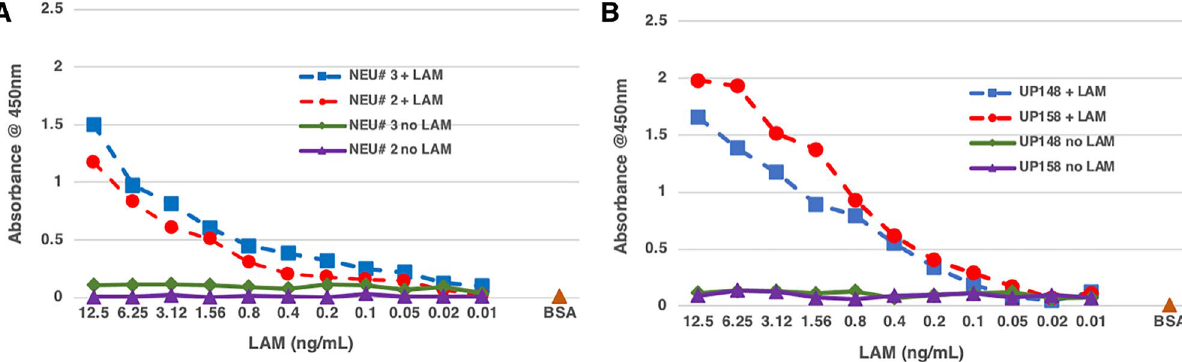
Figure 2. Capture ELISA showing LAM standard curve. Urine from two healthy volunteers (NEU#2, NEU#3) from a TB non endemic region and two clinical samples (UP148, UP158) that were collected from clinically TB negative patients in a TB endemic region were spiked with known amount of LAM and serially diluted two fold (ranging from 12.5 to 0.02 ng/mL) to derive a standard curve and pretreated with Pro K (200 ug/mL). Urine with no LAM but treated with Pro K were used as negative control for background signals. ( A ) Urine from healthy volunteers spiked with LAM show the LoD at ~ 0.05 ng/mL and ( B ) urine from TB negative patients spiked with LAM also show LoD at ~ 0.05 ng/mL. The background signal from urine from one of the healthy volunteers is lower than the signals from the urine from clinical samples with no LAM. This also shows that urine from different sources give varying background levels in an